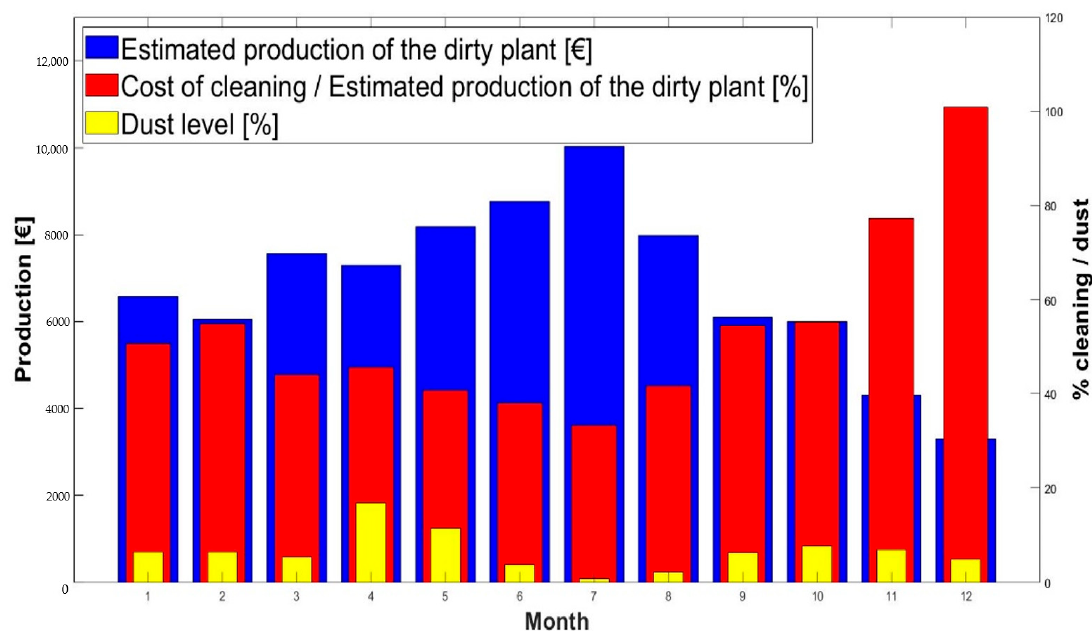
Figure 20. Representation of the minimum dust percentage required to make cleaning the 1 MWp plant profitable.